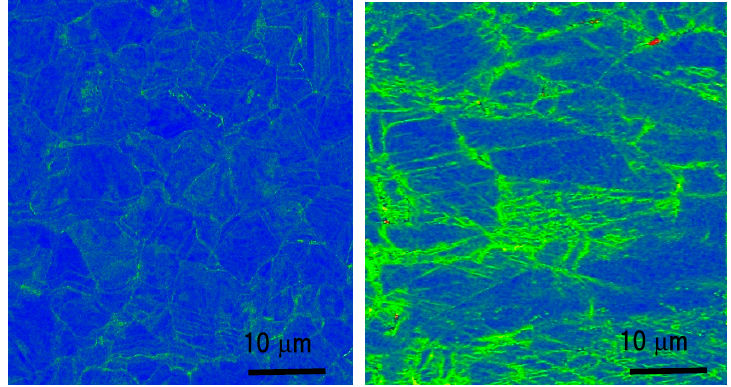
Figure 4. KAM map of SUS 316 TMF.